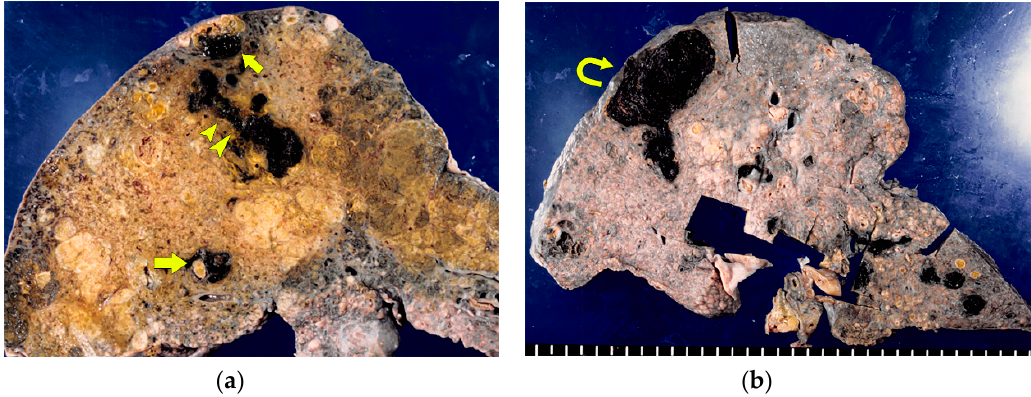
Figure 4. Bile duct necrosis (BDN). ( a ) Photograph of a gross specimen of the cut surface of the liver. There are round-shaped (arrow) and linear (arrow heads) dark green lesions in the right lobe of the liver. These images represent the cross-section and longitudinal cross-section of the necrotic bile ducts. ( b ) Photograph of a gross specimen of the cut surface of the liver. The necrotic bile duct, which shows a dark green tubular structure, is consecutive to the biloma, which shows a large dark green cystic mass like a lesion (curved arrows).